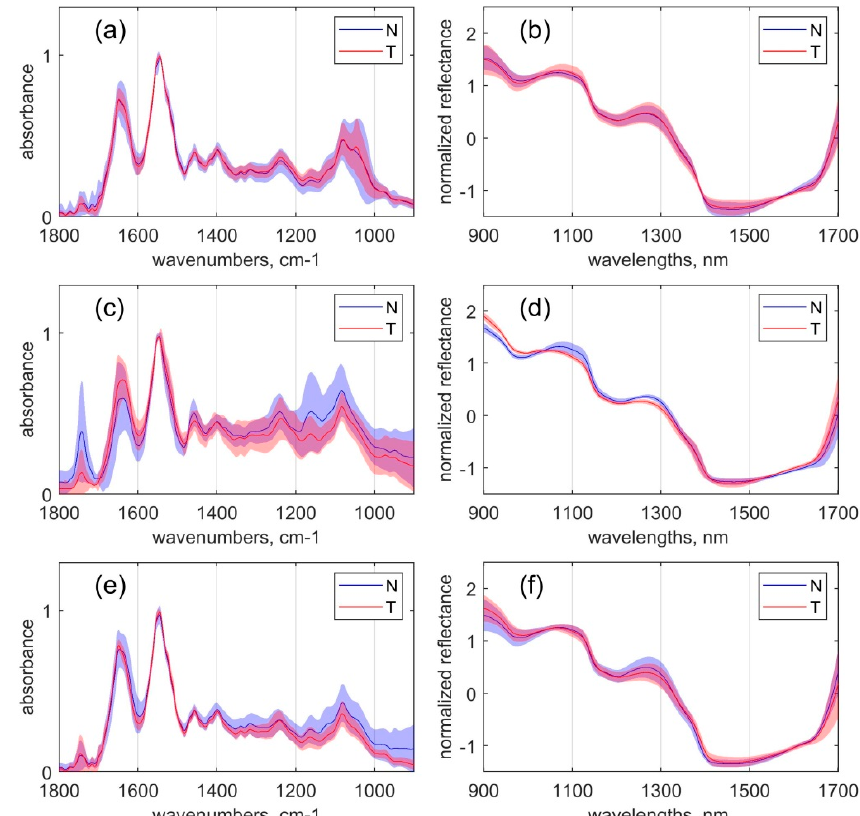
Figure 2. The mean spectra and the standard deviation intervals of tumour (designated as T) and benign (designated as N) samples: ( a ) unpreprocessed mid-infrared (MIR) spectra of colon samples; ( b) smoothed SNV-normalized near-infrared (NIR) spectra of colon samples; ( c ) unpreprocessed mid-infrared (MIR) spectra of rectum samples; ( d ) smoothed SNV-normalized near-infrared (NIR) spectra of rectum samples; ( e ) unpreprocessed mid-infrared (MIR) spectra of stomach samples; ( f ) smoothed SNV-normalized near-infrared (NIR) spectra of stomach samples. The curves and the surrounding coloured regions represent the mean spectra and the standard deviation intervals of the respective data variables.